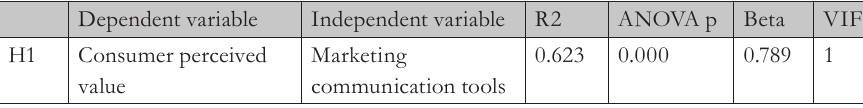
Tab. 4 – Regression analysis data. Source: own